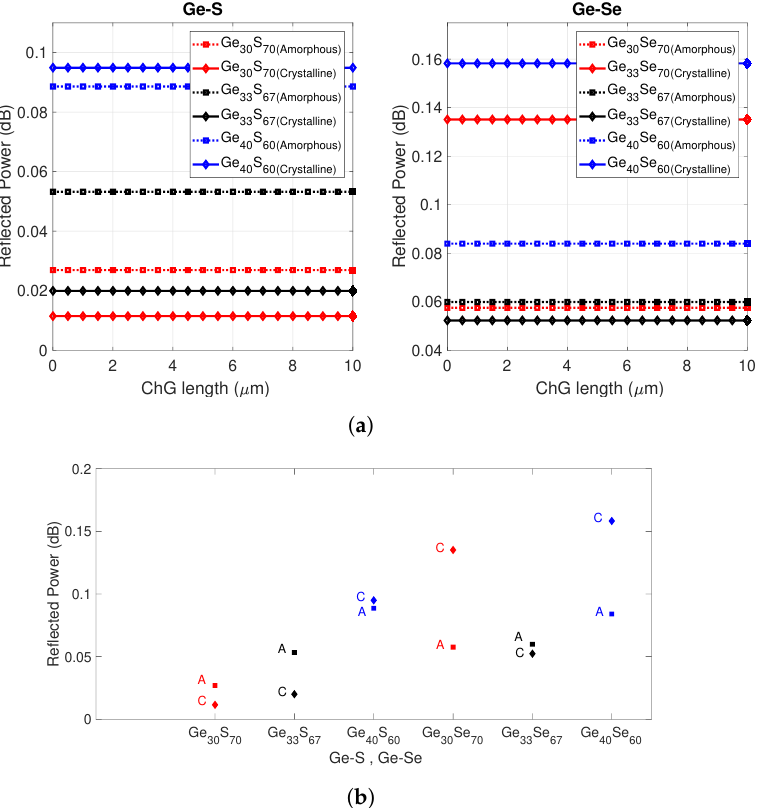
Figure 3. ( a ) Normalized reflected power of the fibers capped with in-house synthesized Ge-S (left) and Ge-Se (right) compositions. The solid curve indicates crystalline phase and the dashed-dotted curve indicates amorphous phase. ( b ) Normalized reflected power of Ge-Se- and Ge-S-capped fiber tips in amorphous and crystalline phases.